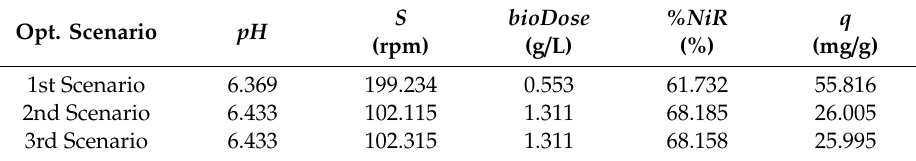
Table 11. Adsorption capacity of the olive stone waste.